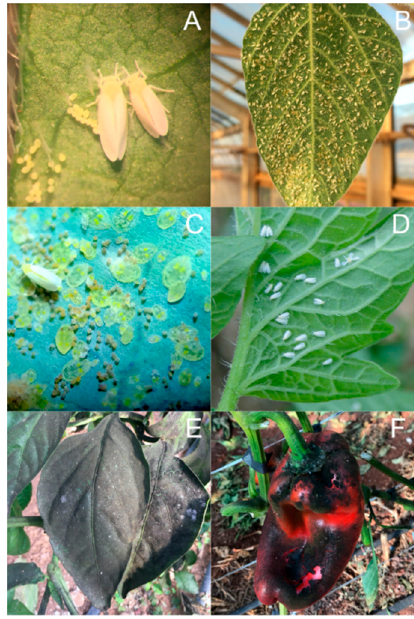
Figure 1. ( A ) Eggs and adults of Bemisia tabaci . ( B ) A large infestation of B. tabaci on the abaxial side of the soybean leaflet. ( C ) Different life stages of Bemisia tabaci colonizing and feeding on a cabbage leaf. ( D ) Adults of Trialeurodes vaporariorum feeding on the abaxial side of a tomato leaf. ( E , F ) Sooty mold covering sweet pepper leaves and fruits.